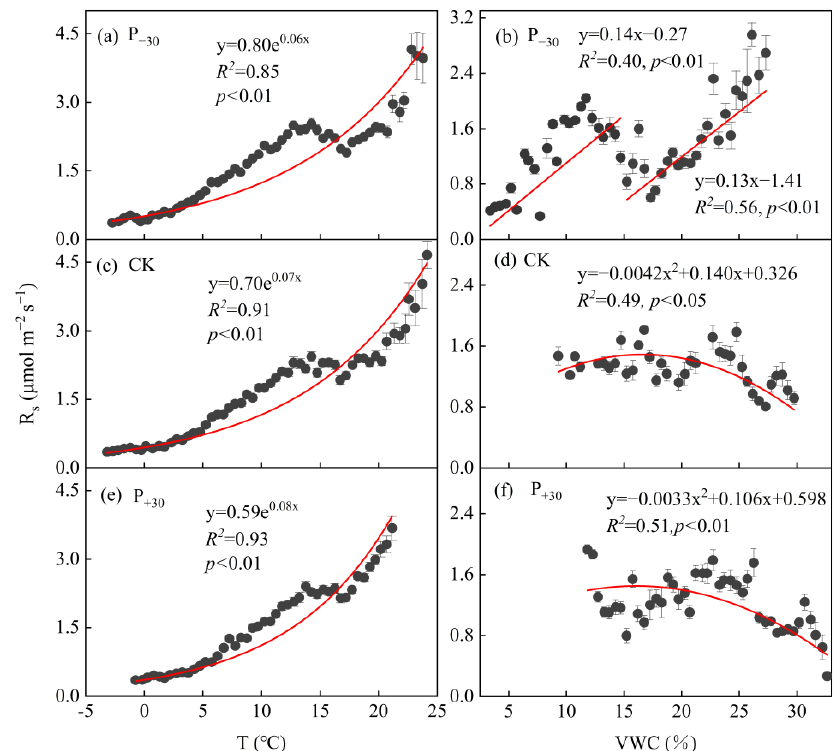
Figure 3. Correlations of soil respiration (R s ) with soil temperature (T s ) ( a , c , e ) and soil volumetric water content (VWC) ( b , d , f ) in the different precipitation treatments (P − 30 = 30% decreased precipitation, CK = ambient precipitation, P +30 = 30% increased precipitation) during the winter wheat whole growth period. The exponential function was used for fitting R s and T s (R s = a × e bT ). The piecewise linear function (R s = a × VWC + b) of the response of R s to VWC in the P − 30 treatment (bounded by 15% of VWC) and the logarithmic function for R s and VWC (R s = a × VWC 2 + b × VWC + c) in the CK and P +30 treatments, respectively. The red lines indicates the significant relationship between R s and T s or VWC. Error bars represent standard errors of the mean. Hourly values were bin-averaged every 0.5 intervals of T s and VWC. Table 2. Regression equations of soil respiration (R s ) against soil temperature (T s ) and soil volumetric water content